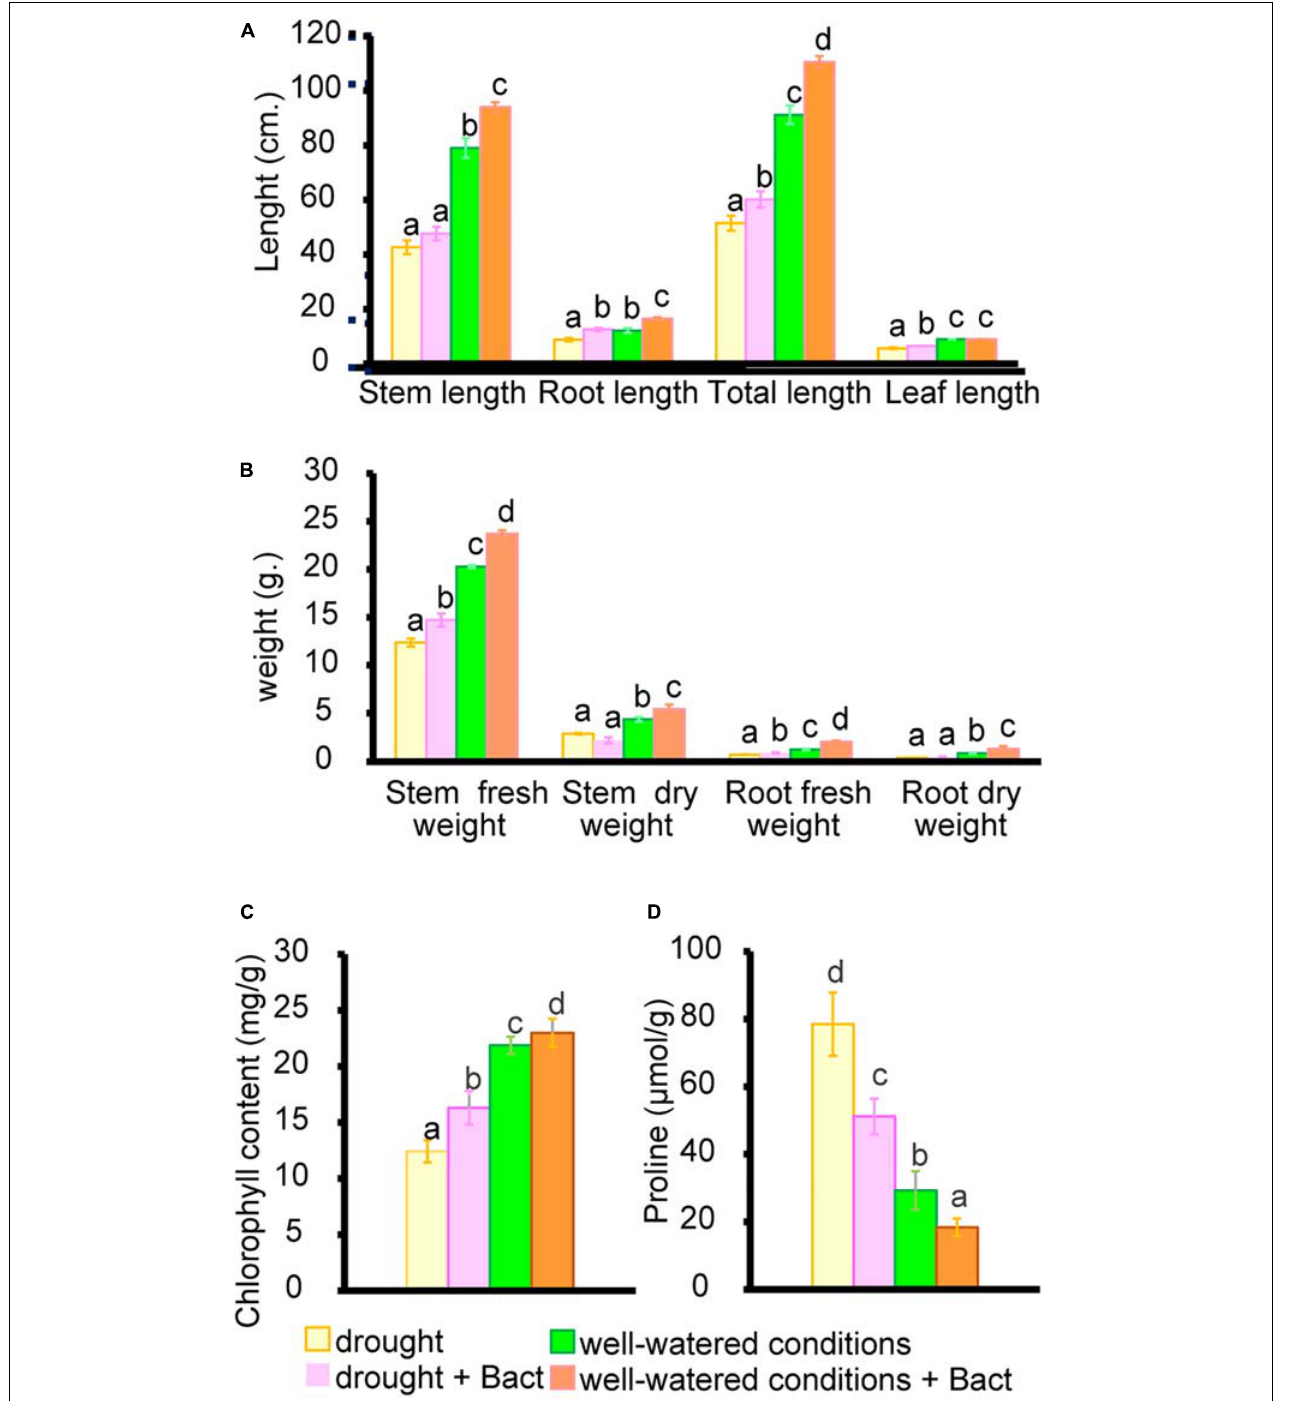
FIGURE 8 | Growth parameters and proline content of cowpea ( V. unguiculata ) in well-watered and drought conditions with/without B. aryabhattai MoB09. (A) Stem root leaf and total length. (B) Fresh weight, dry weight of stem and root. (C) Chlorophyll contect and (D) Proline contents.